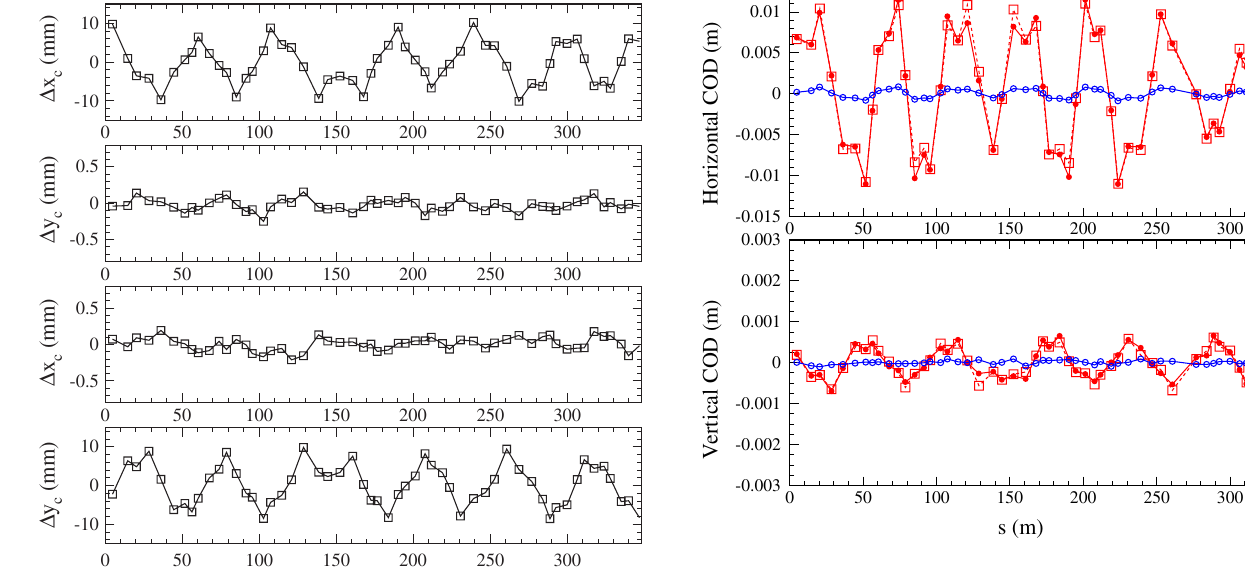
FIG. 13. (Color) Horizontal (upper) and vertical (lower) COD caused by the leakage field from ESEP excited at 181 MeV (open blue circles) or at 3 GeV (closed red circles) measured in the 181 MeV beam storage mode, in which open red squares show the COD obtained in the model fitting for the closed red circle data.